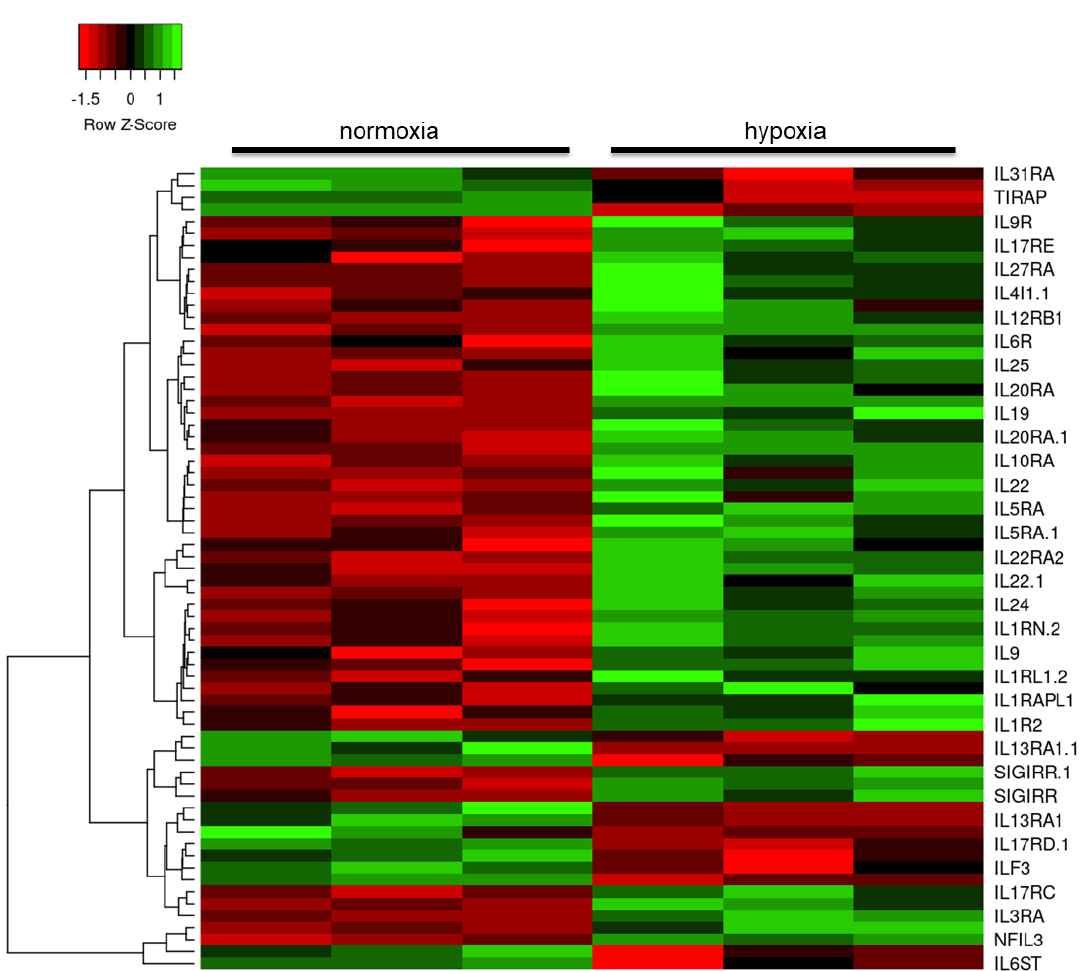
Figure 3. Heat map of interleukin gene expression changes in human astrocytes in response to hypoxia. Red: downregulated transcripts; green: upregulated transcripts.